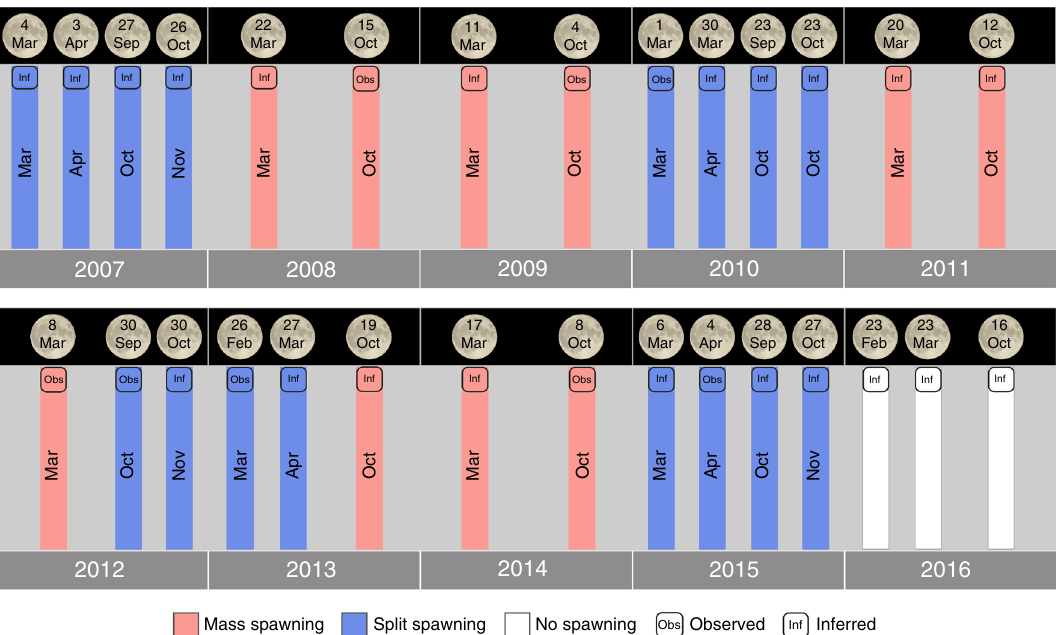
Fig. 1 Coral spawning records for Scott Reef from 2007 to 2016. Spawning was either observed in situ or inferred from egg presence/absence and egg pigmentation around predicted spawning dates. When the full moon occurred in the middle (8th – 22nd) of the usual March or October spawning month, then single-mass spawning occurred. However, when the full moon occurred early, in the fi rst week of the usual spawning month, or the last week of the previous month, then split spawning occurred. The only exception to this rule was the mass spawning event after an early full moon on the 4th October in 2009. Full moon dates are given in the moon icons above the bars. Pink bars indicate mass spawning and blue bars indicate split spawning. The white bars in 2016 indicate no spawning due to a severe coral bleaching event. More detail on these spawning records are presented in Supplementary Table